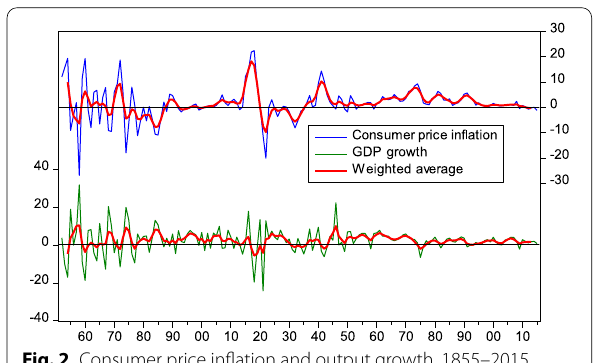
Fig. 2 Consumer price inflation and output growth,